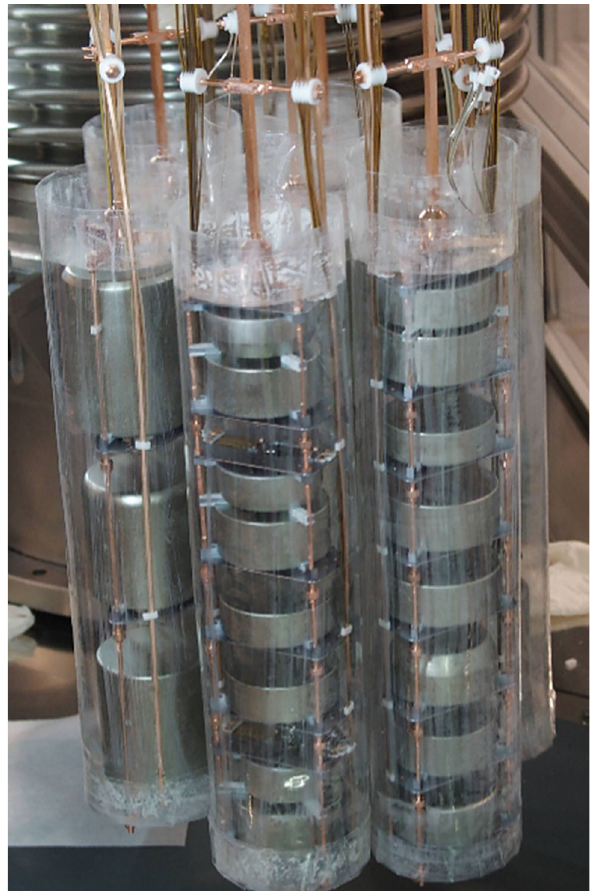
Fig. 31 Photo of Gerda Phase II detector array, showing from left to right string 2 with three semi-coaxial detectors, and strings 3 and 4 with eight BEGe detectors, respectively. Each of the seven strings is enclosed by a transparent mini-shroud